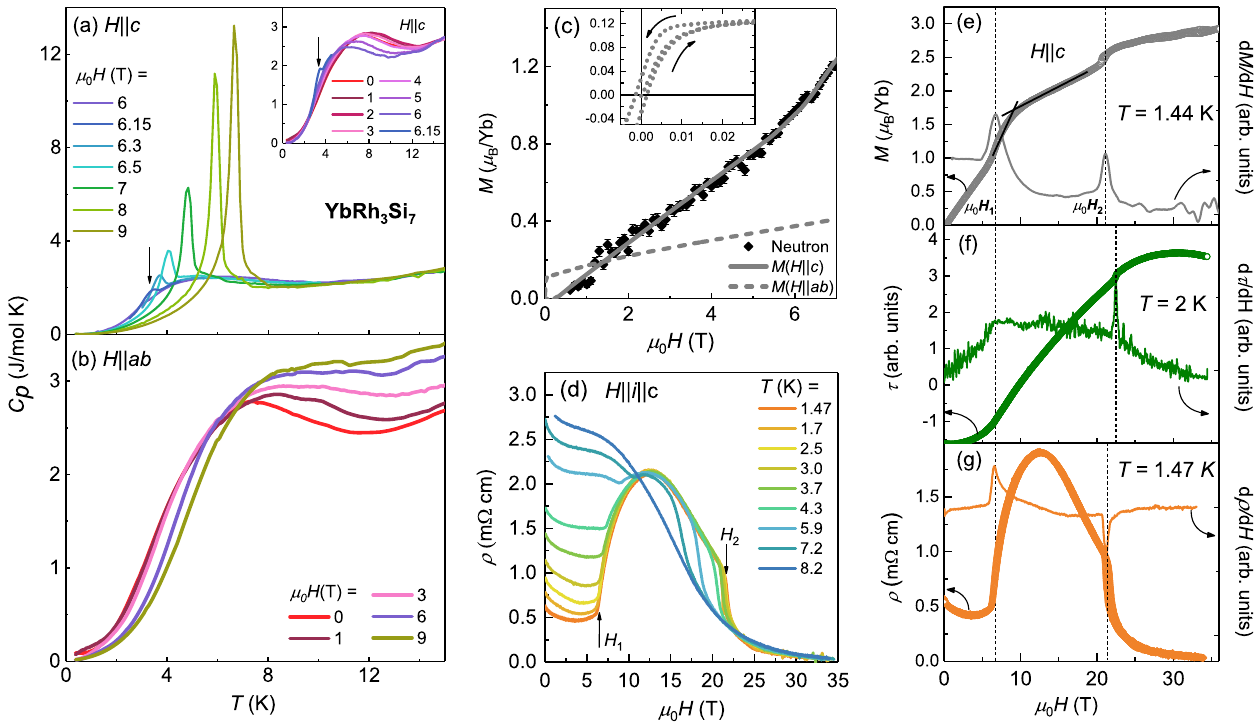
FIG. 3. (a) C p vs T for YbRh 3 Si 7 with magnetic fields ( μ 0 H ≥ 6 T) applied parallel to the c axis. Inset: Low magnetic-field data ( μ 0 H ≤ 6 . 15 T). (b) C p vs T with H jj ab . (c) M vs H at T ¼ 1 . 8 K for H jj ab (dashed line) and H jj c (solid line) up to μ 0 H ¼ 7 T. The c - axis moment from neutron diffraction is given by the solid symbols. The inset shows the low-field data for H jj ab . (d) H jj c magnetoresistance isotherms. (e) – (g) Left axis: Magnetization at T ¼ 1 . 44 K, torque at T ¼ 2 K, and resistivity at T ¼ 1 . 47 K as a function of magnetic field H jj c . Right axis: Derivative plots with respect to H . Dashed lines indicate the metamagnetic transitions at μ H μ H 0 1 and 0 2